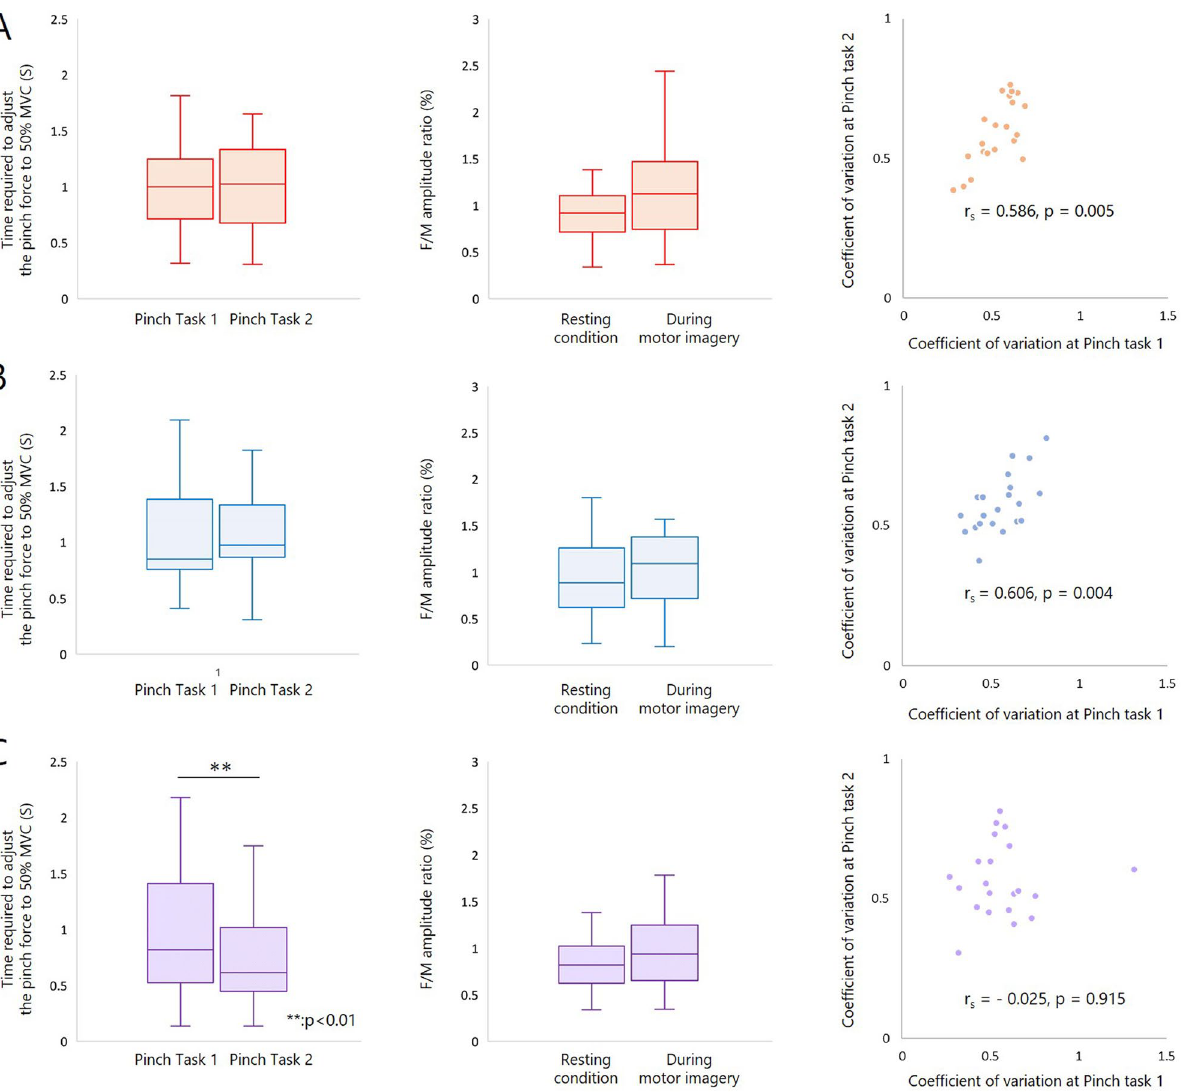
pinch task (r = 0.06, p = 0.768). There were no significant differences in the F/M amplitude ratio between the resting and KMI conditions (r = 0.30, p = 0.170). In the KMI condition, positive correlations were found between the coefficient of variation for each pinch task (r s = 0.586, p = 0.005). ( B ) In the number visualizing condition, there were no significant differences in the time required to adjust the pinch force to 50% MVC between each pinch task (r = 0.04, p = 0.848). There were no significant differences in the F/M amplitude ratio between the resting and number visualizing conditions (r = 0.32, p = 0.140). In the number visualizing conditions, positive correlations were found between the coefficient of variation for each pinch task (r s = 0.606, p = 0.004). ( C ) The time required to adjust the pinch force to 50% MVC was significantly shorter for the pinch task 2 than pinch task 1 in KMI with number visualizing condition (r = 0.69, p = 0.002). There were no significant differences in the F/M amplitude ratio between resting and KMI with number visualizing conditions (r = 0.28, p = 0.205). No correlations were observed between the coefficient of variation for each task in KMI with number visualizing condition (r s = − 0.025, p =